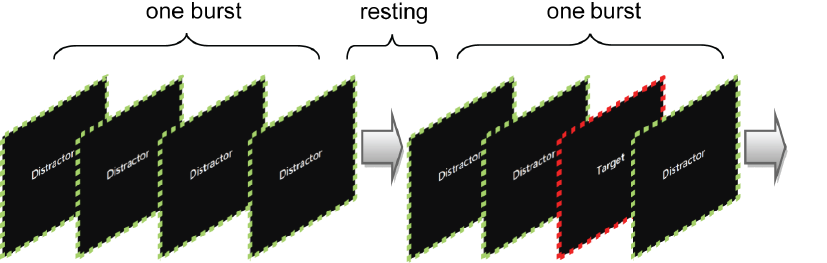
Figure 1. RSVP paradigm. One burst consisted of 50 images, each of which was presented for 100 ms. There was a maximal 10-sec resting period between consecutive bursts. The target image was highlighted